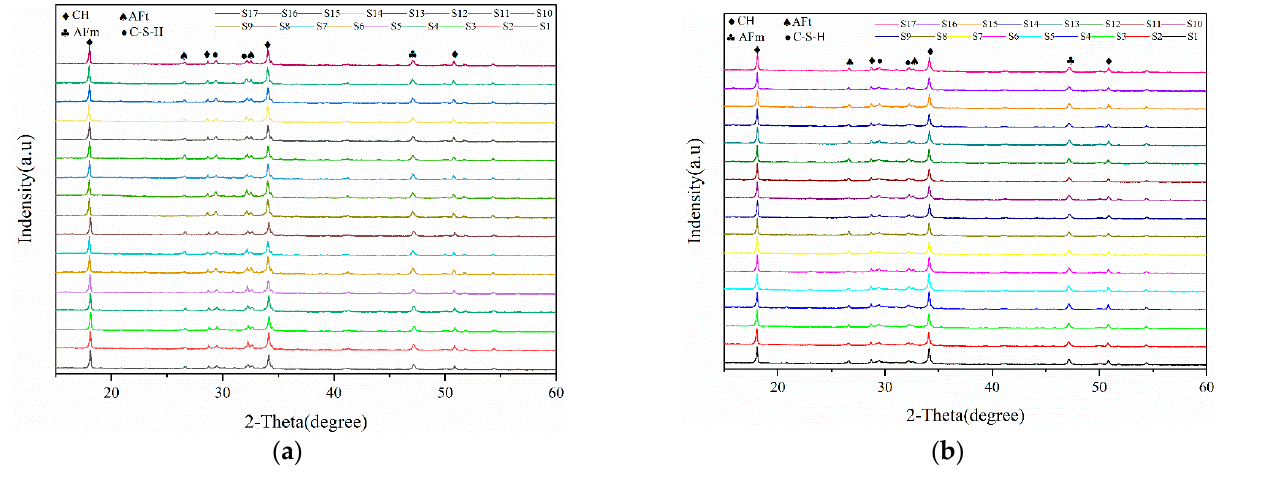
Figure 16. XRD patterns of samples at 3 days ( a ) and 28 days ( b ). D is the average thickness of the crystal grains perpendicular to the crystal plane, crystal size (nm); K is the Scherrer constant, equal to 0.89; γ is the X-ray wavelength, equal to 0.1549 nm; B is the half-height width of the sample diffraction peak (rad); θ is the diffraction angle (rad).